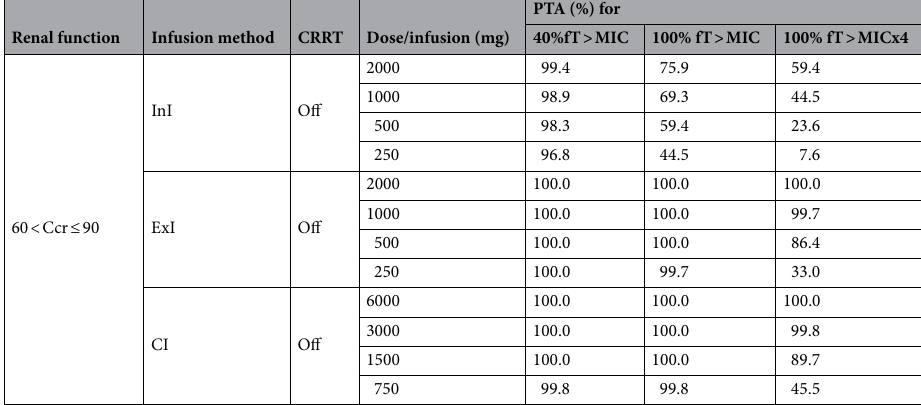
Table 4. Results of simulation showing probability of target attainment by administering doripenem in different dosing regimens against Pseudomonas aeruginosa with MIC ≤ 2, under various conditions of renal function and continuous renal replacement therapy. InI intermittent infusion, ExI extended infusion, CI continuous infusion, fT > MIC time in which free drug concentrations exceed MIC, PTA probability of target attainment, CRRT continuous renal replacement